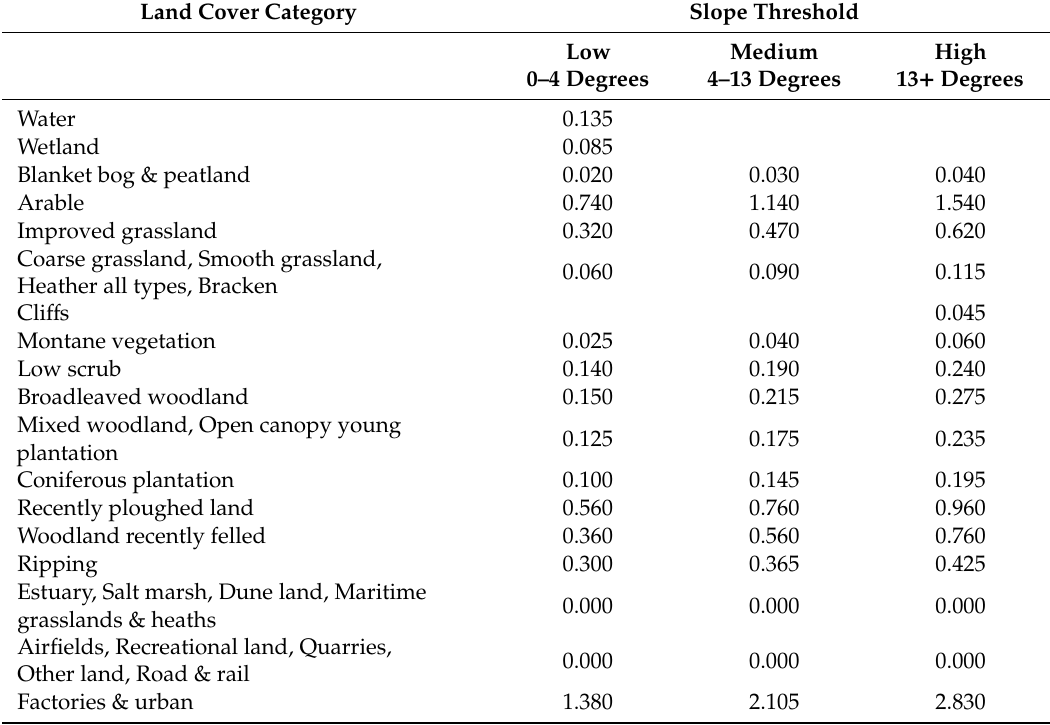
Table 1. Land cover and slope TP export coe ffi cients (kg / ha / yr) from Ferrier et al.